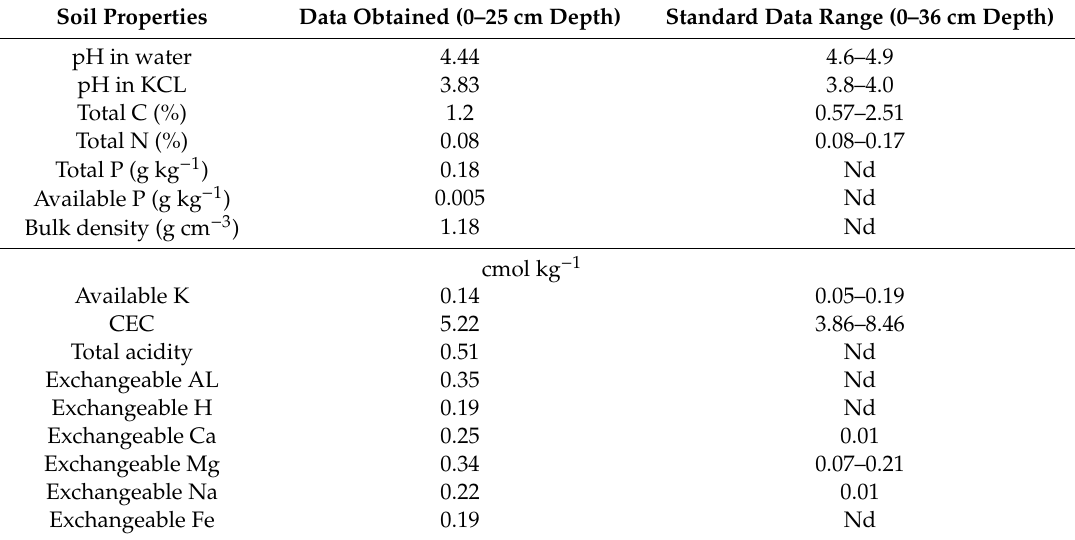
Table 4. Selected chemical and physical properties of Bekenu series (Typic